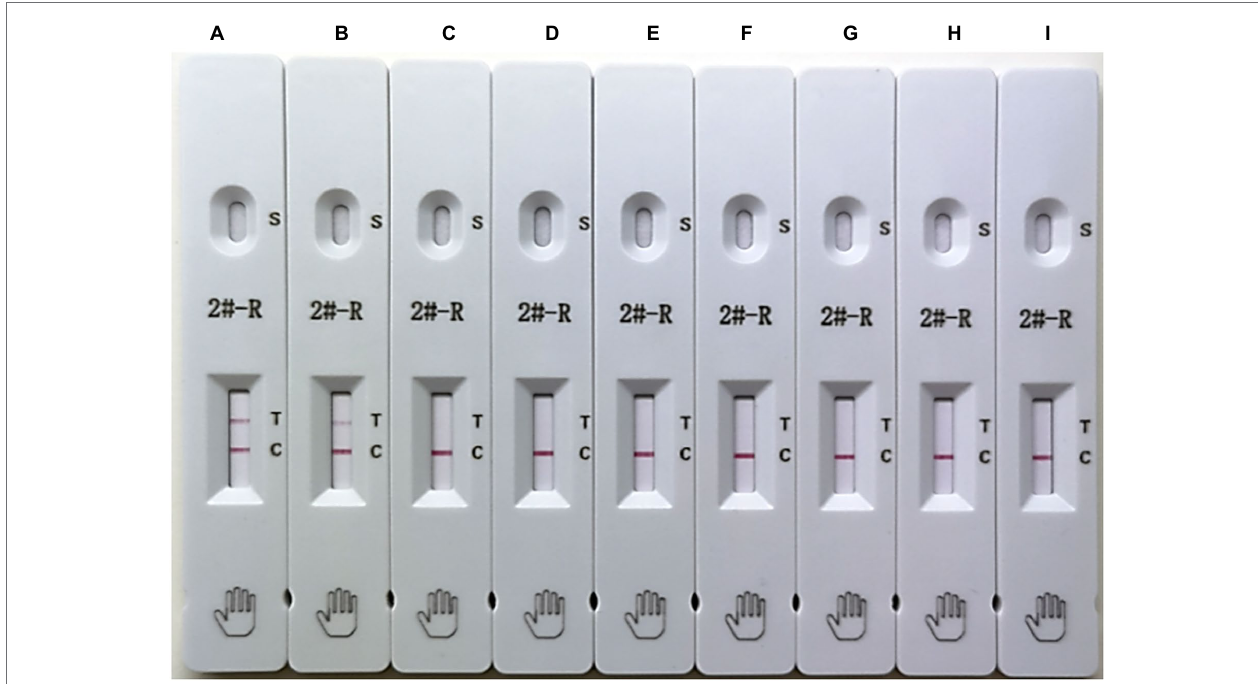
FIGURE 4 | Testing of the specificity of the ICS. The following viruses were tested using the ICS assay developed in this study: HuN4 (HP-PRRSV; strip A ), SDHS53 (NADC30-like PRRSV; strip B ), DV (EU-PRRSV; strip C ), porcine parvovirus (PPV; strip D ), porcine circovirus type 2 (PCV-2; strip E ), classical swine fever virus (CSFV; strip F ), transmissible gastroenteritis virus (TGEV; strip G ), porcine pseudorabies virus (PRV; strip H ), and porcine epidemic diarrhea virus (PEDV; strip I